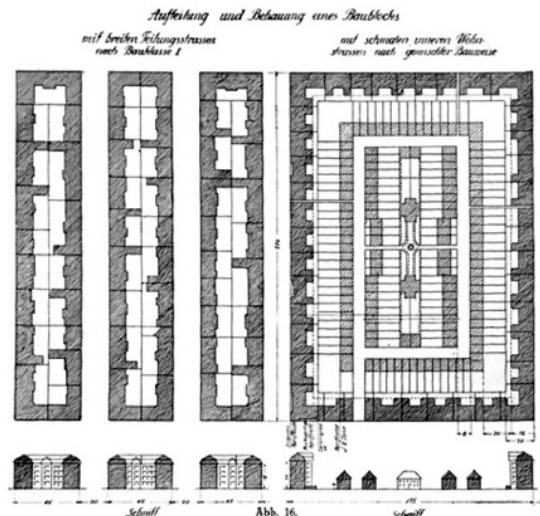
Figure 3. 1910 Groß Berlin competition, B. Möhring, R. Eberstadt, R. Petersen, 1910, Subdivision and construc- tion of a building block. Proposal for mixed housing ty- pologies. Source: Wettbewerb Gross-Berlin (1910).